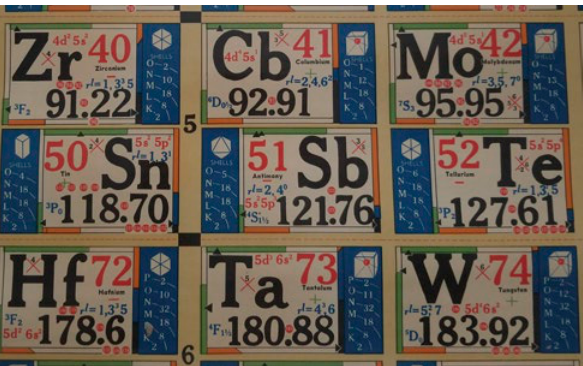
Figure 4. Detail from the 1947 edition of the Periodic Chart of the Atoms (Welch Scientific Company) showing element 41 with the name columbium, as well element 74 with the symbol W and the name tungsten (Photo taken by the author; table in author’s per- sonal